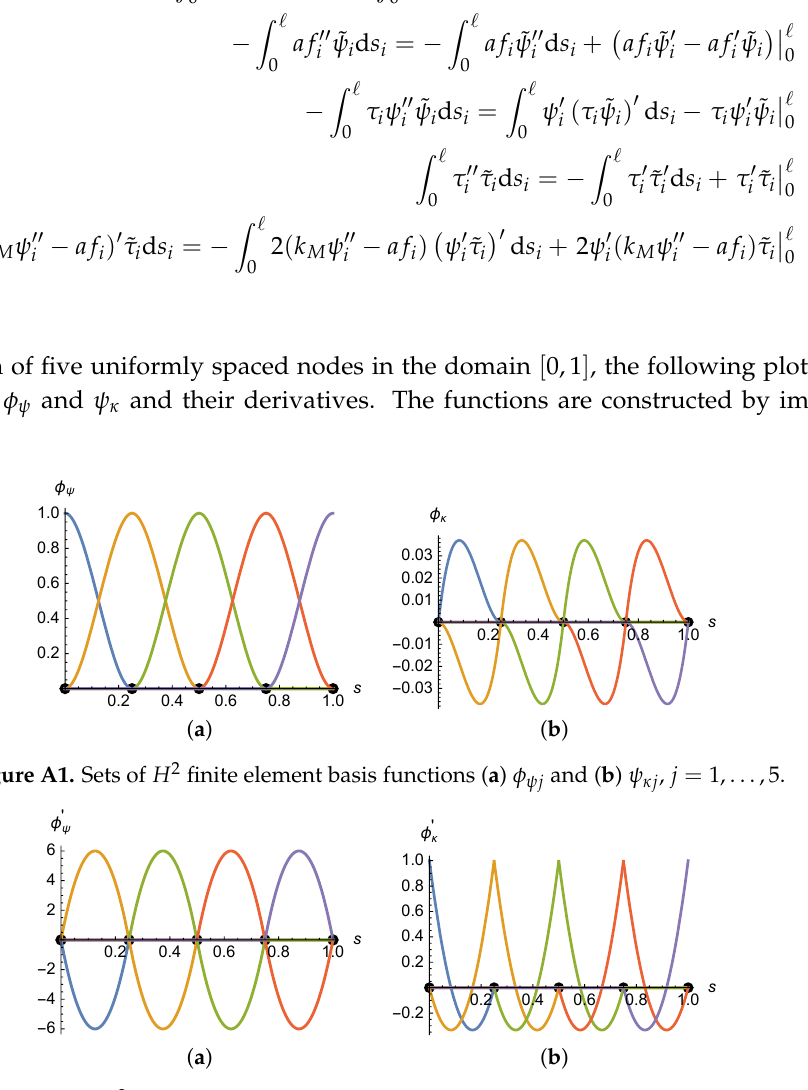
Figure A2. Sets of H 2 finite element basis function derivatives ( a ) φ (cid:48) Basis functions φ τ are plotted in Figure A3.